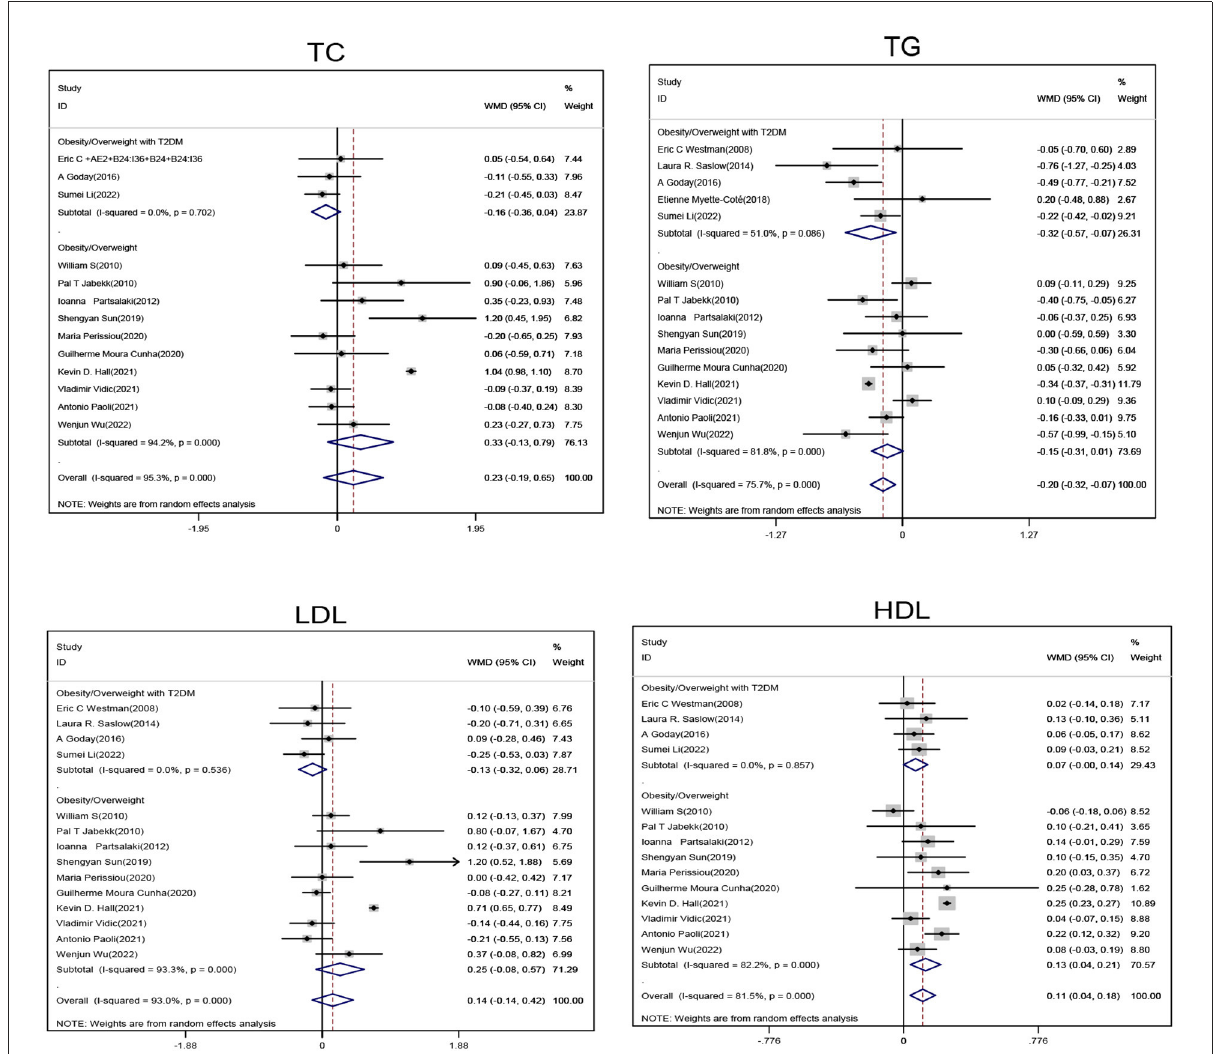
FIGURE2 Forest plot showing weighted mean difference and 95% confidence intervals (CIs) for low carbohydrate ketogenic diet effects on lipid metabolism. TC, Total cholesterol; TG, Triglyceride; LDL, Low density lipoprotein; HDL, High density